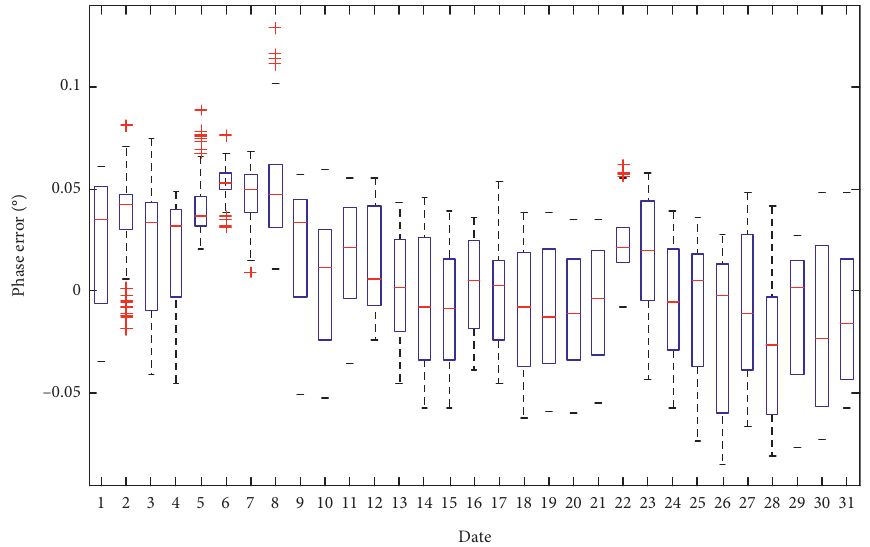
Figure 5: Boxplot of the ET phase error data.